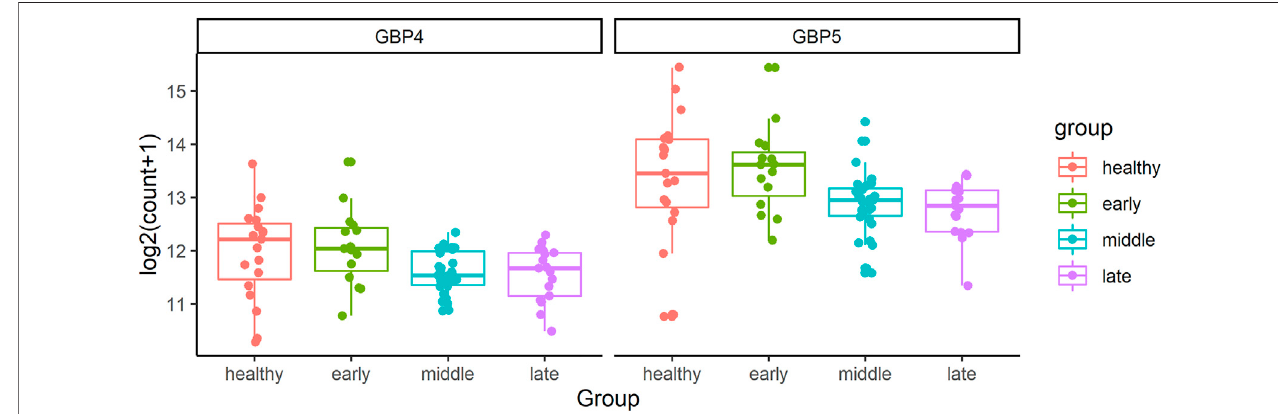
FIGURE6| Thechangesof GBP4 and GBP5 ingeneexpressionovertimefromthebulkRNA-seqdata.TheFDRadjusted p -valuesoftheoveralldifferenceacross three stages (using R package DESeq2) for GBP4 and GBP5 are 0.00156 and 0.00111, separately.